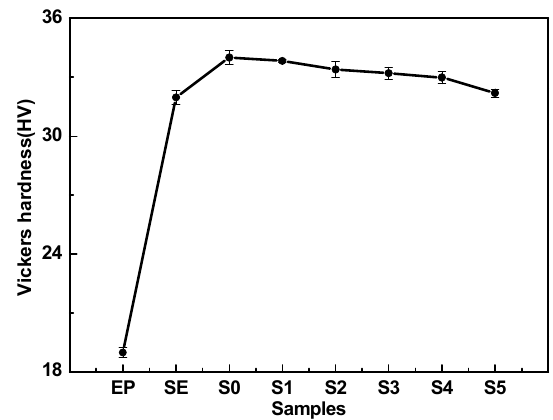
Figure 6. Vickers hardness of EP composites.